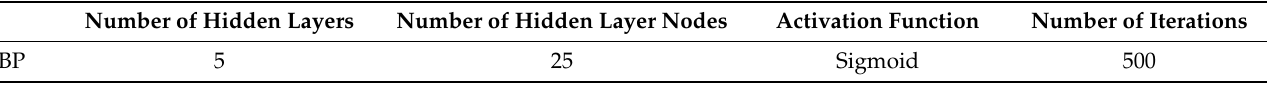
Table 1. Parameters setting of base learners.